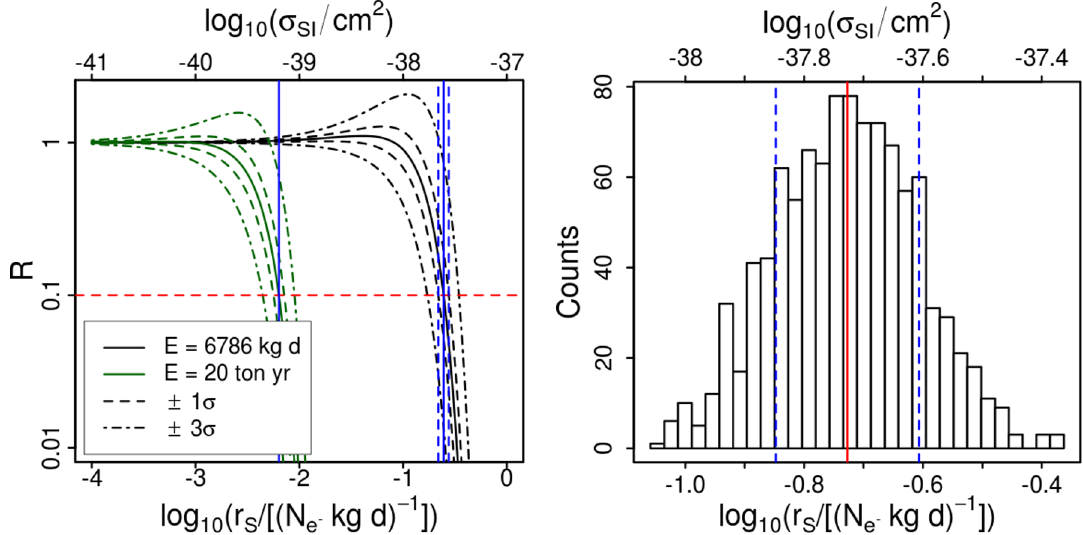
Figure 4 . Left : Bayes factor for a Migdal-only signal at m (cid:31) = 1 GeV/ c 2 and n = 1 ; 2 obtained using pseudo-datasets generated from the background-only likelihood with the current DarkSide-50 exposure E = 6786 kg d (black lines) and an exposure E = 20 ton y (green lines), which is (cid:24) 10 3 times the current exposure. The dashed lines and the dashed-dotted lines represent the Bayes factor computed varying the expected rate by (cid:6) (cid:27) and (cid:6) 3 (cid:27) , respectively. Right : histograms of r S (90% C : I : ) for a Migdal-only signal at m (cid:31) = 1 GeV/ c 2 and n = 1 ; 2 obtained using pseudo- datasets generated from the background-only likelihood with an exposure E = 6786 kg d